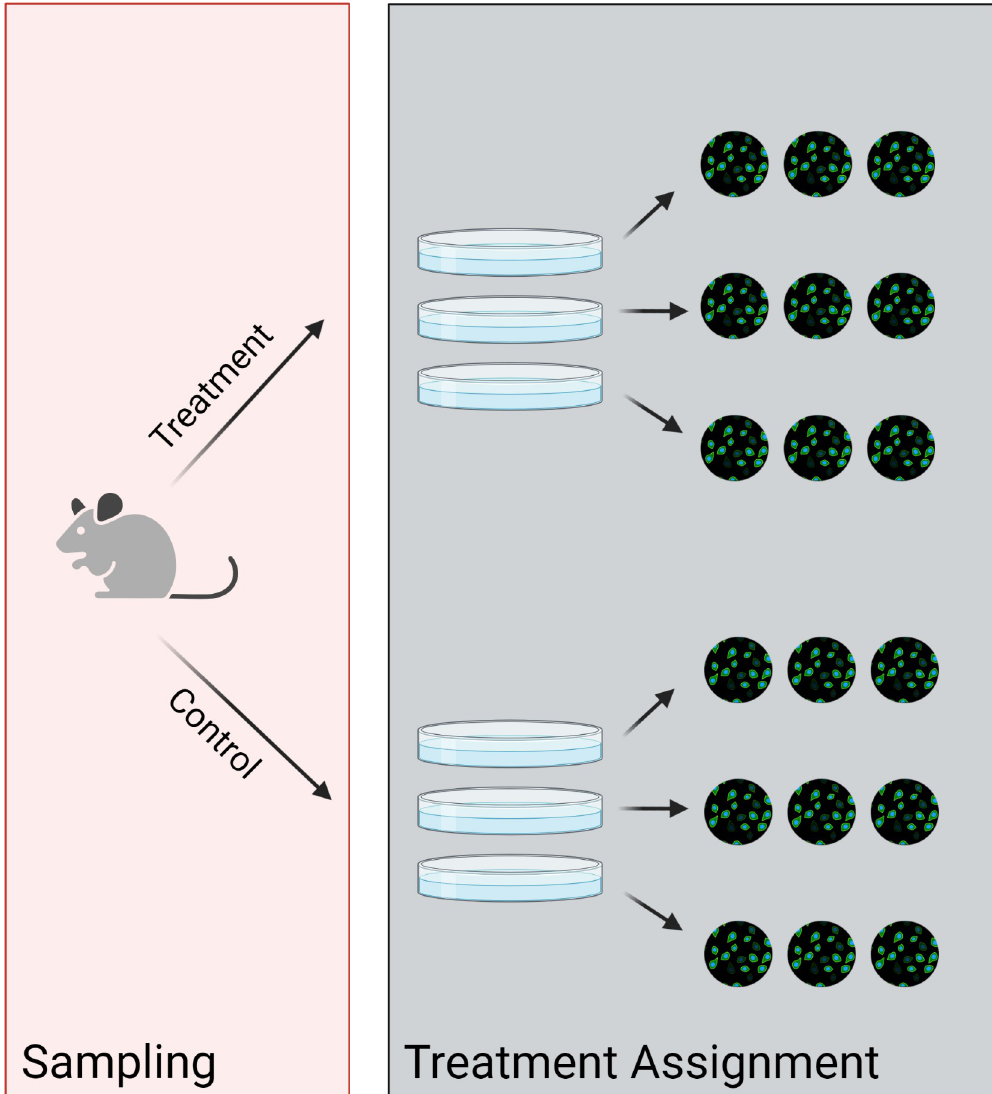
Fig 2. Hierarchy arises during sampling and treatment assignment. Hierarchy due to sampling occurs when the sampled entities and the treated entities are not the same. Hierarchy due to treatment occurs when the treatment entities and the observed entities are not the same. Figure was created using